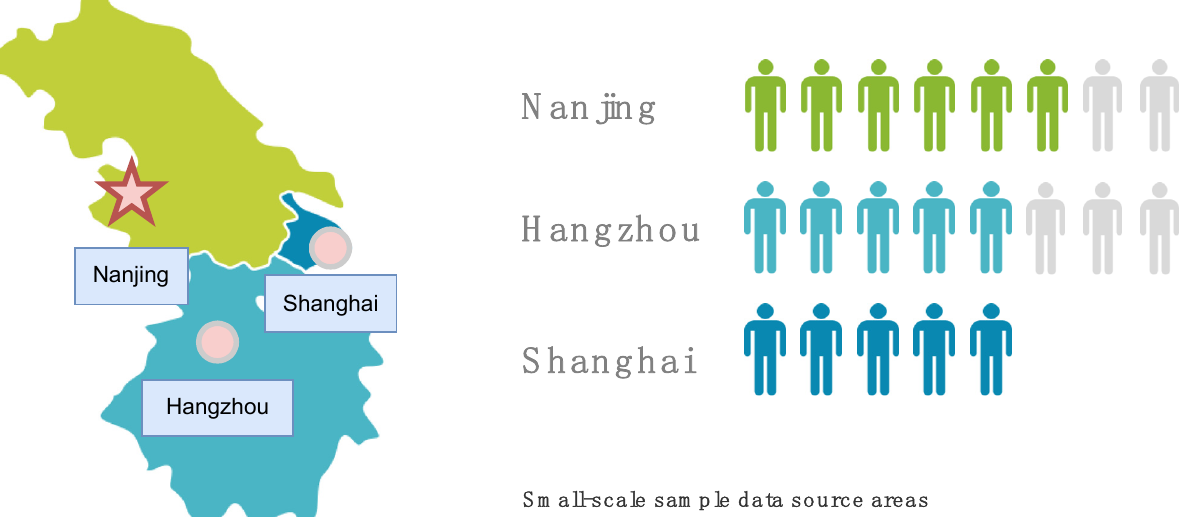
Figure 5. Qualitative study design.